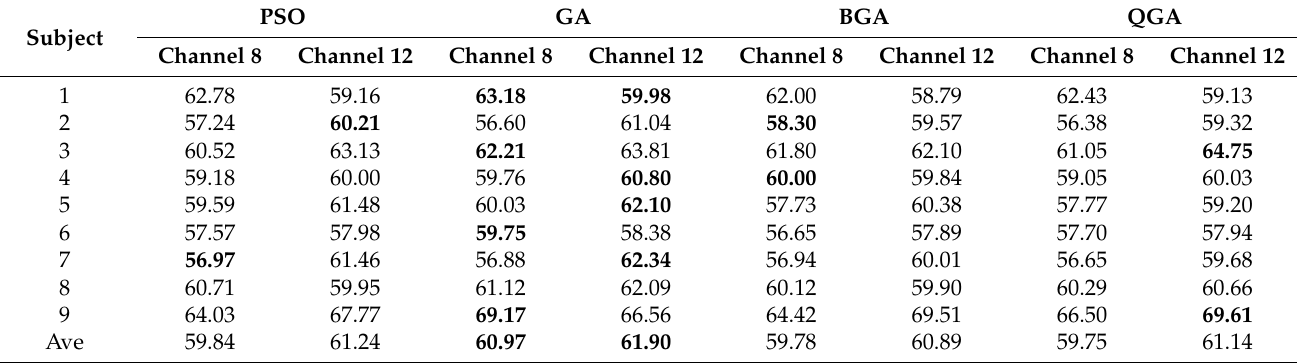
Table 12. The results of algorithms with four methods (TD, FD, wavelet, and autoregression) on a single channel (C3 = 8 or C4 = 12) with FB 2 & 5